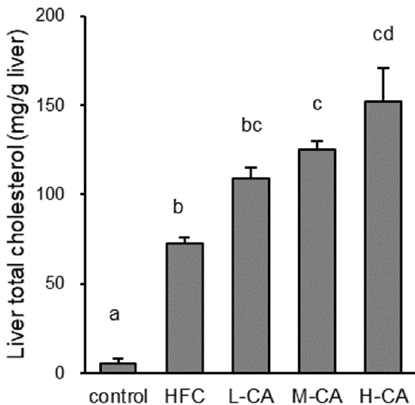
Figure 2. Cholesterol content of the liver in the control, HFC, and L-CA, M-CA and H-CA groups. Values are expressed as means ± SE. n = 5–6/group. a,b,c,d values not sharing the same lowercase letter are significantly different among groups ( p < 0.05). HFC, high-fat and high-cholesterol; L-CA, M-CA and H-CA, the HFC diet with 0.1%, 0.5% and 2.0% sodium cholate ( w / w ), respectively.